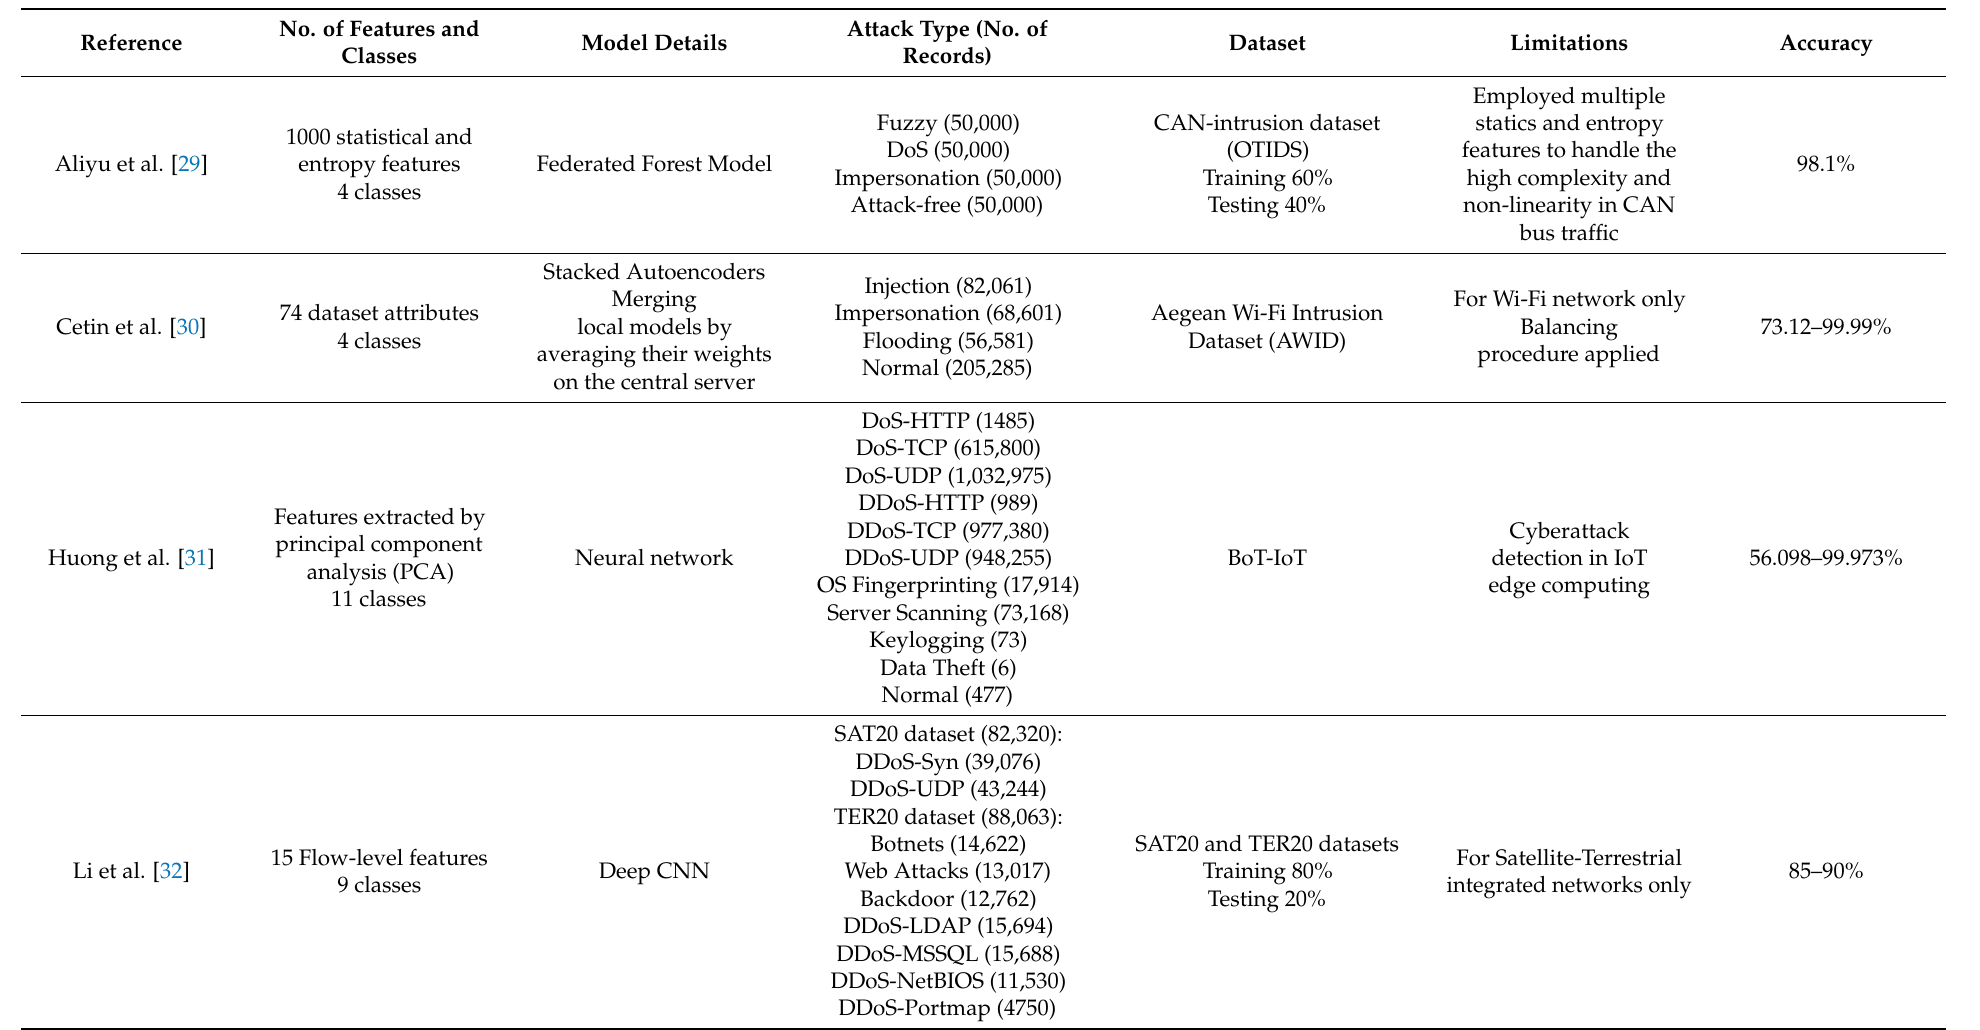
Table 1. List of state-of-the-art research papers on federated learning for network intrusion